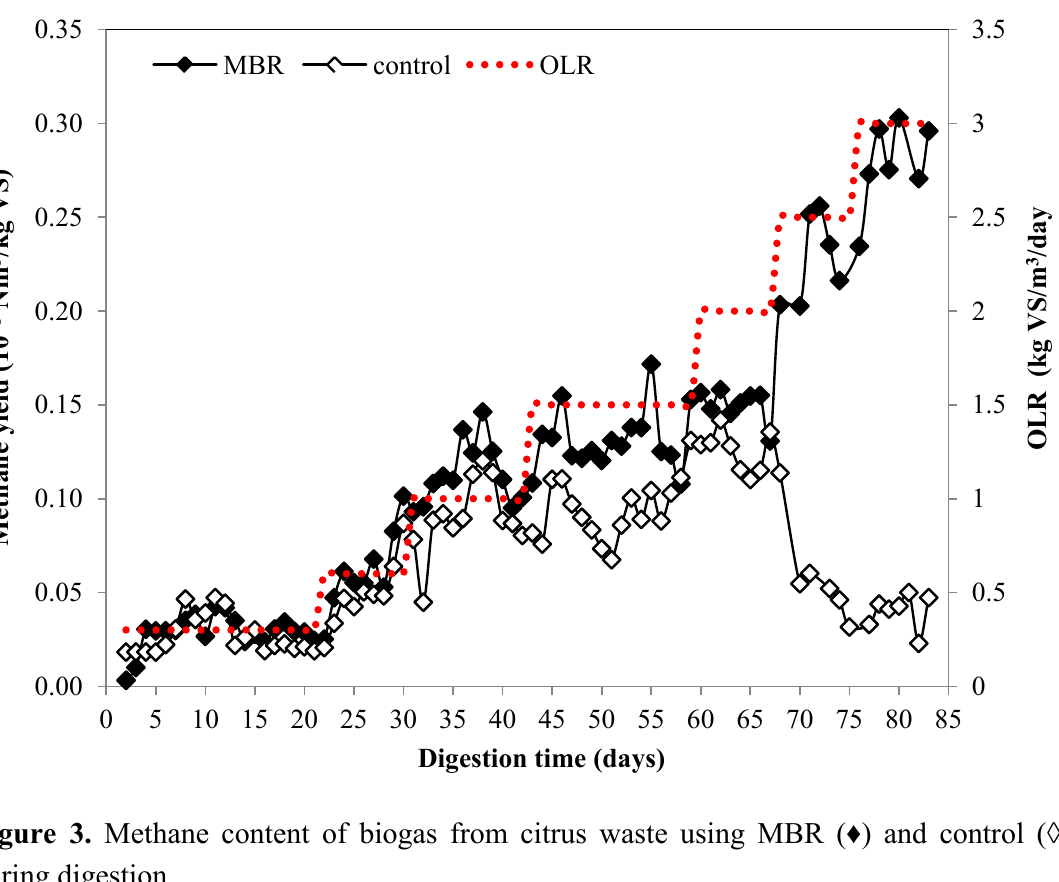
Figure 2. Methane production of anaerobic digestion from citrus waste using MBR and control at different organic loading rate.